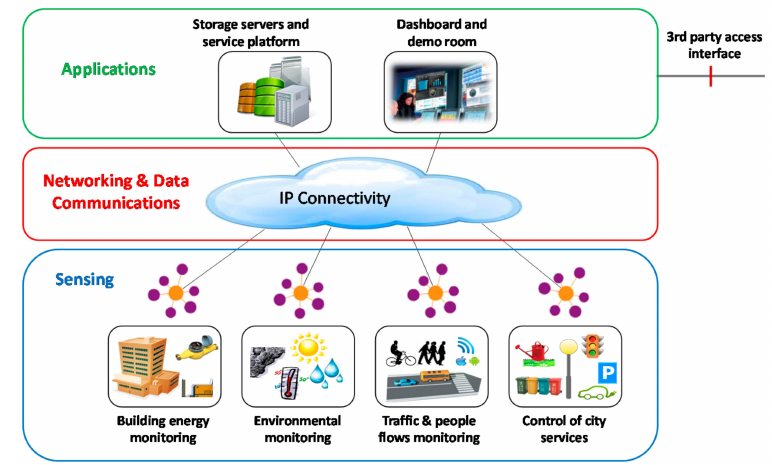
Figure 3. Overview of the system architecture and main layers of the Smart CEI